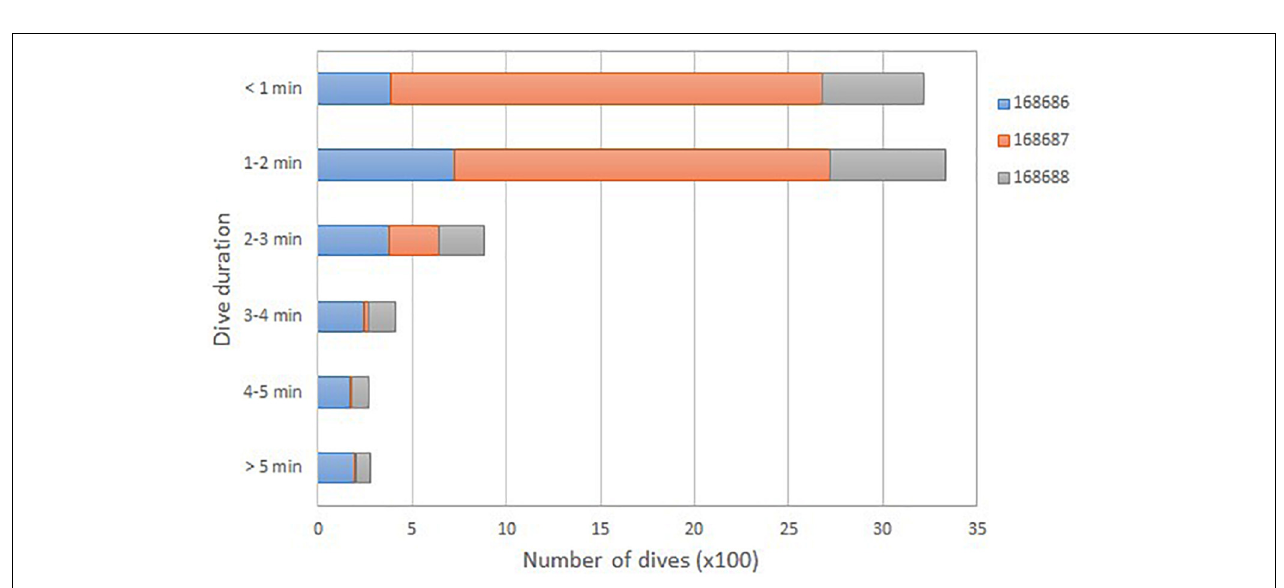
FIGURE 7 | Total number of dives (100 × ) for three satellite-tagged humpback whales (identified by PTT ID) grouped into 1-min dive duration bins.